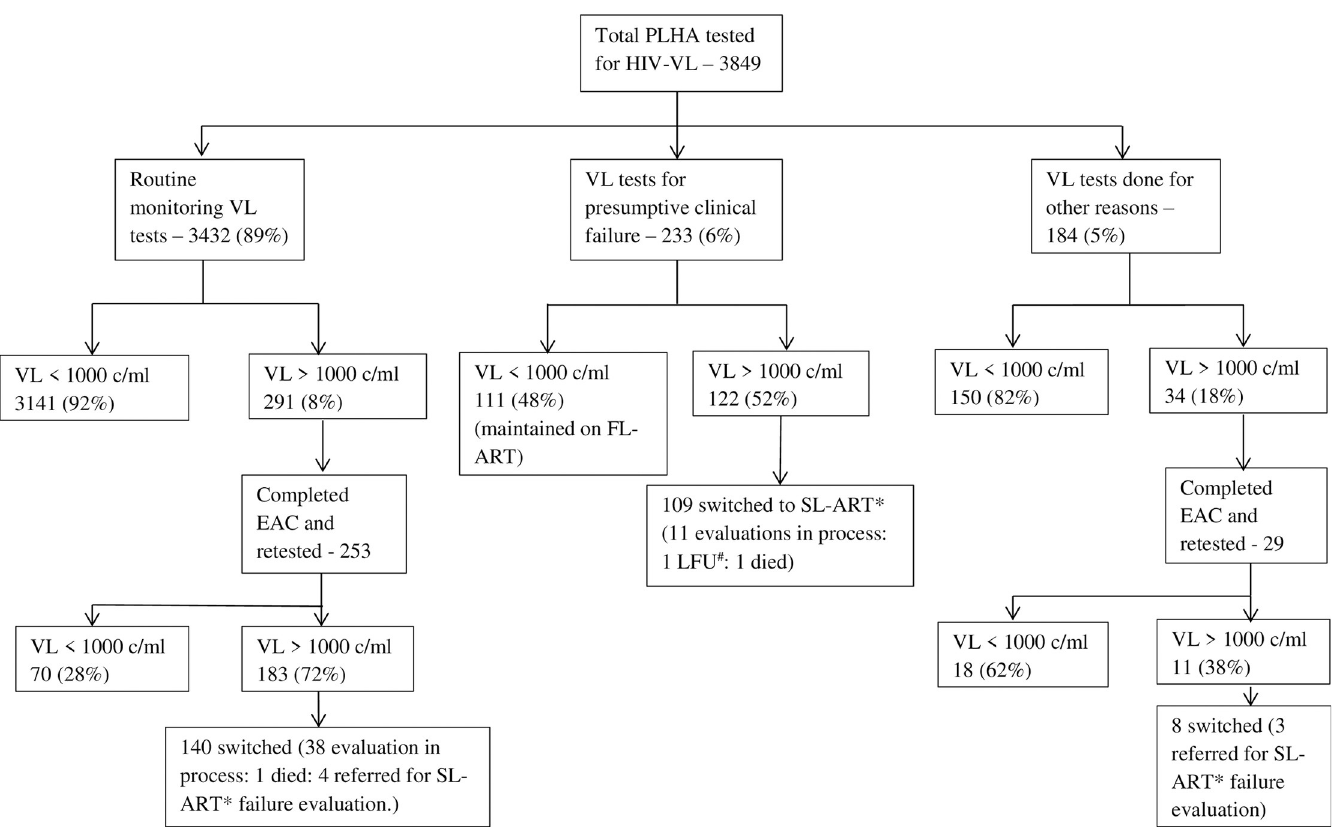
Fig 1. HIV viral-load testing cascade among people living with HIV/AIDS on ART at KEM hospital, Mumbai, India. � Second Line Anti-retroviral therapy: # Lost to follow up.